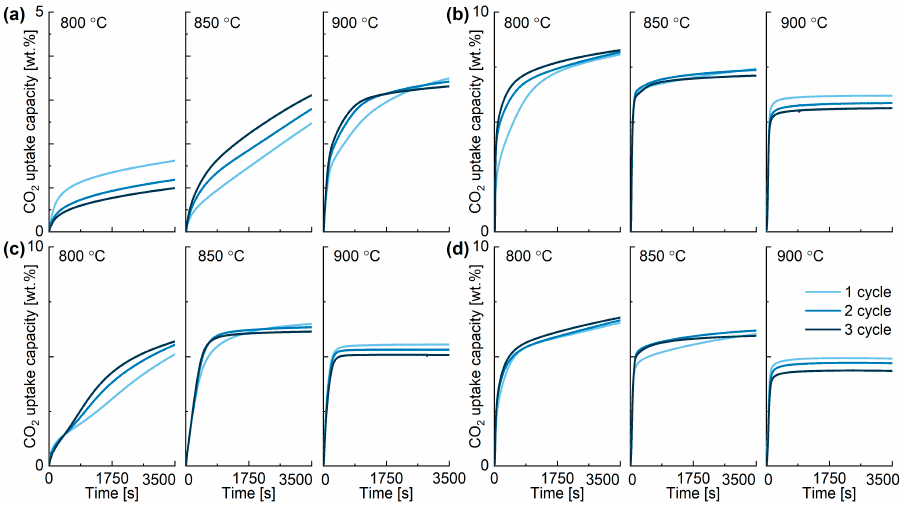
Figure 4. Performance of in-house synthesised potassium stannates ( a ) K-A, ( b ) K-B, ( c ) K-C, ( d ) K-D under different temperatures at 800, 850, 900 °C. Table 2. Performance of stannates synthesised in-house.